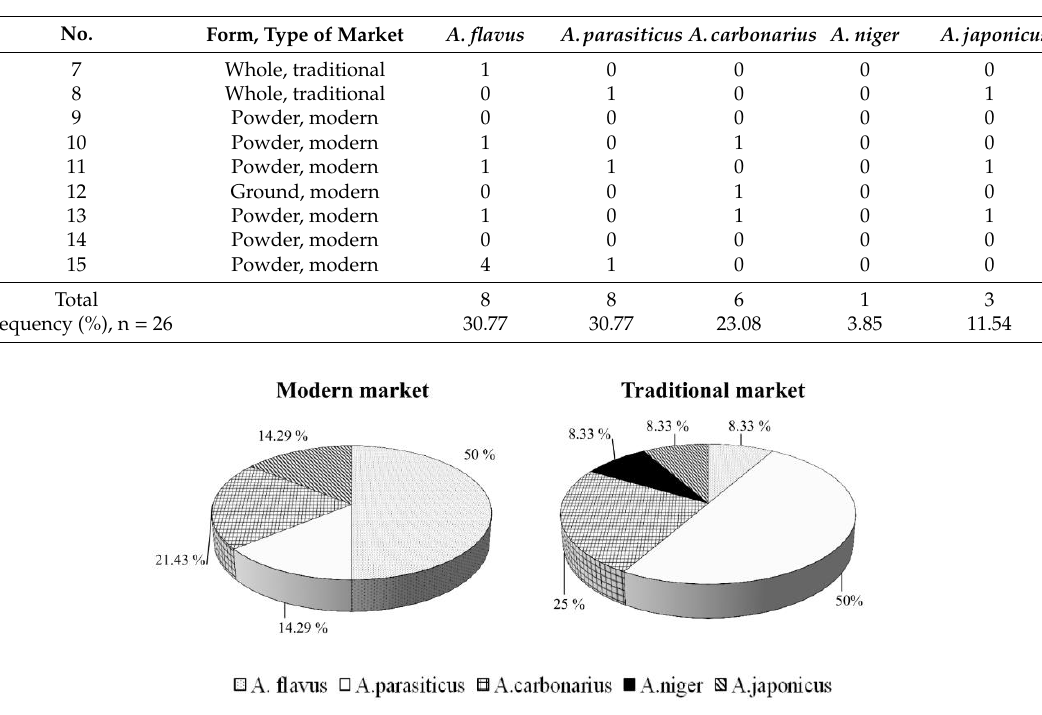
Figure 3. Frequency of Aspergillus spp. detected in dried and powdered chili from the traditional and the modern markets.